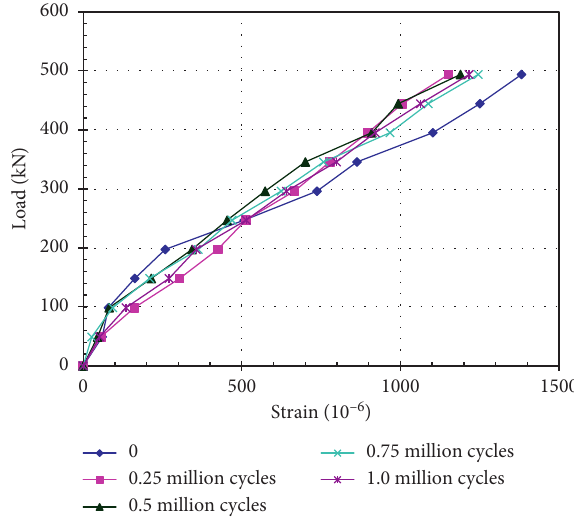
Figure 26: PLG-1 reinforcement strain comparison of midspan concrete slab.